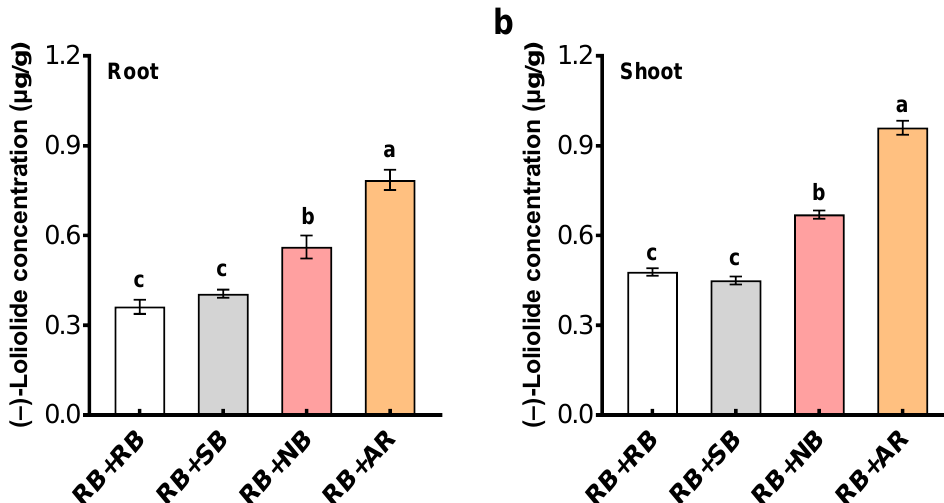
Figure 5. (–)-Loliolide levels in root ( a ) and shoot ( b ) of penoxsulam-resistant barnyardgrass ( RB ) in response to the presence of penoxsulam-susceptible barnyardgrass ( SB ) and normal barnyardgrass ( NB ), as well as allelopathic rice cultivar ( AR ). Values plotted are means plus/minus SE. Columns with the same letter are not significantly different at p < 0.05 according to ANOVA, followed by Tukey HSD tests.